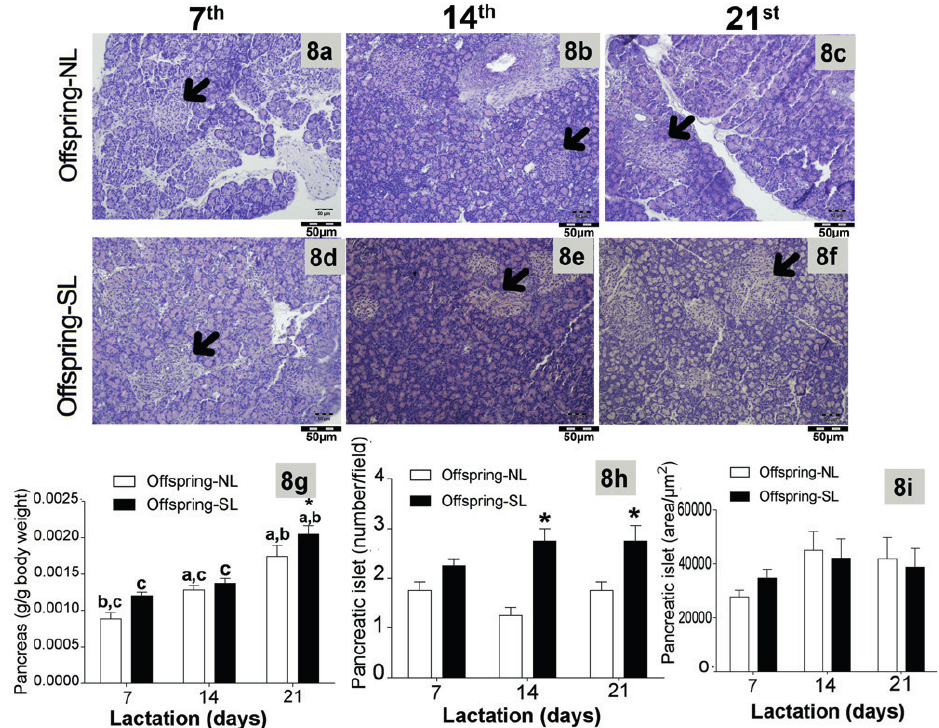
Figure 8 - Histological analysis of the endocrine pancreas from SL-offspring and NL-offspring in different lactational phases. The values are expressed as mean ± Standard Error of the Mean (n= 9-12 animals/group). The symbol above bars indicates a significant difference (p<0.05) between the groups (Two-way ANOVA with uncorrected Fisher´s LDS: * SL versus NL; a 7 th day of lactation; b 14 th day of lactation and c 21 st day of lactation). The arrows in the image indicate the pancreatic